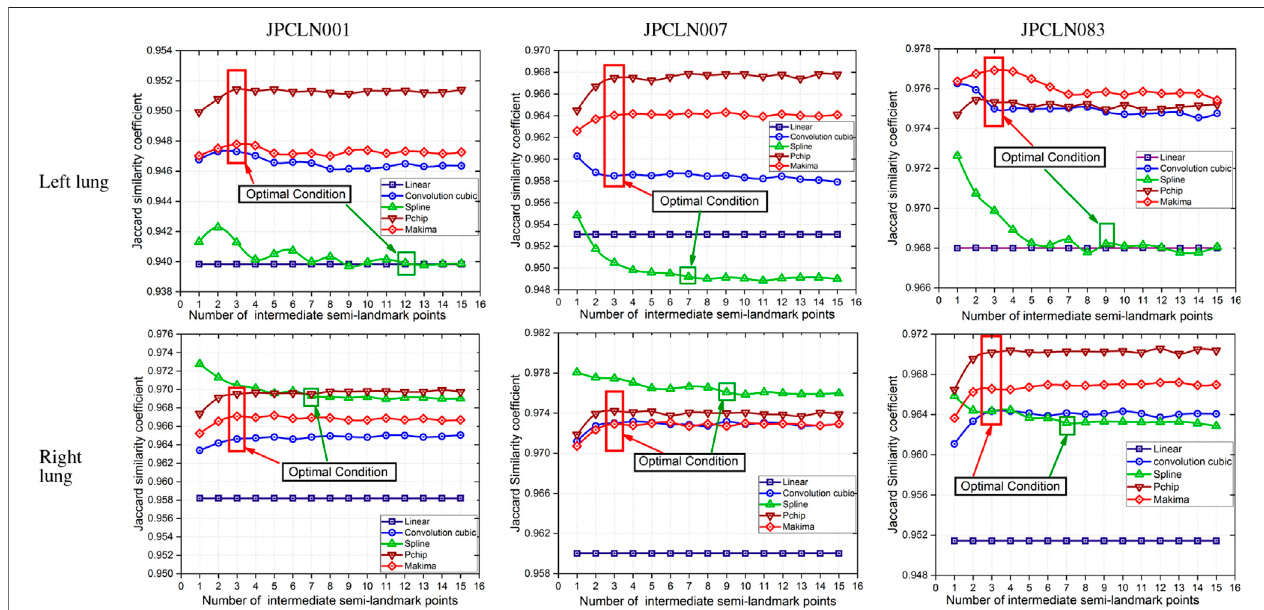
FIGURE 5 | Jaccard similarity coef fi cients of the modeled shape with different piecewise polynomial interpolation methods of the left and right lung fi eld regions of the image datasets JPCLN001, JPCLN007, and JPCLN083.